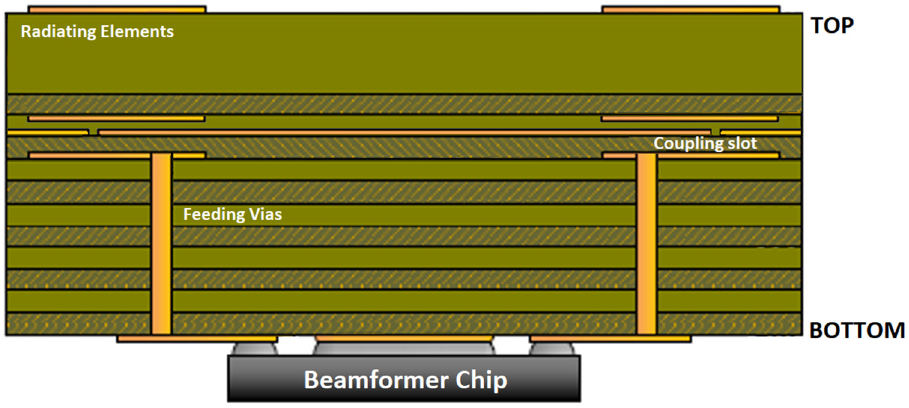
Figure 1. Cross-section of the Ka-band antenna array.